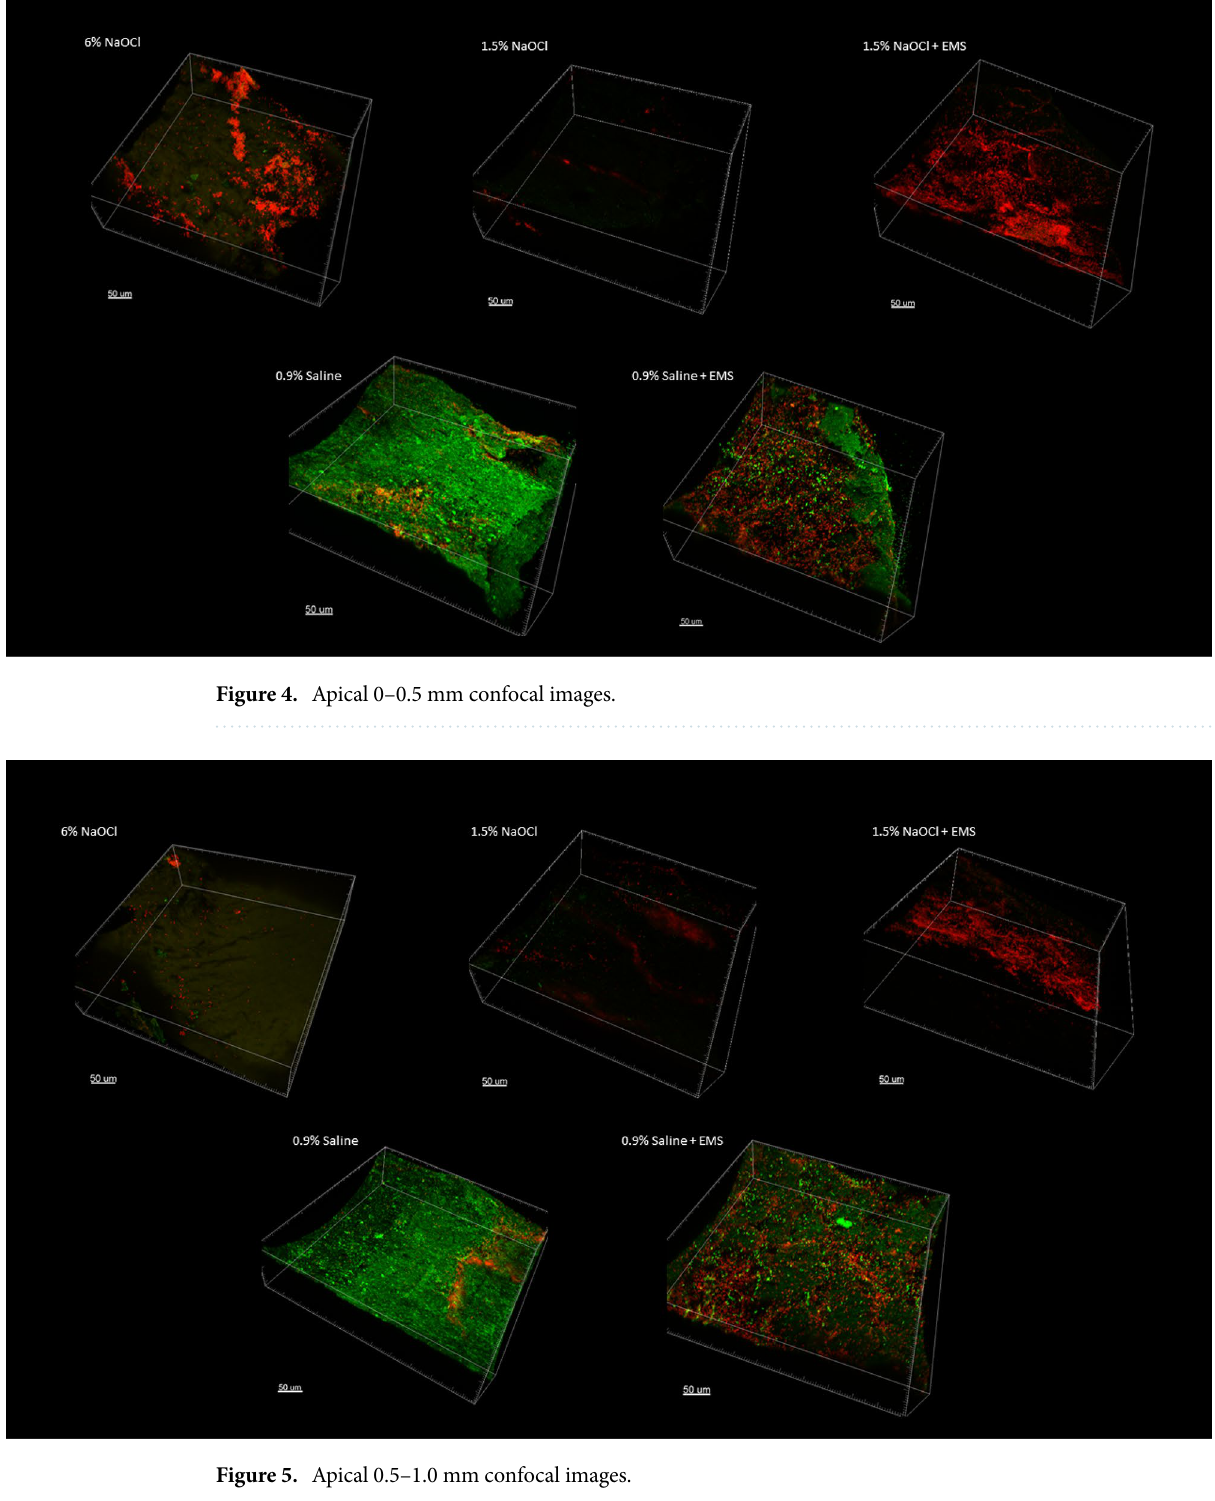
Figure 5. Apical 0.5–1.0 mm confocal